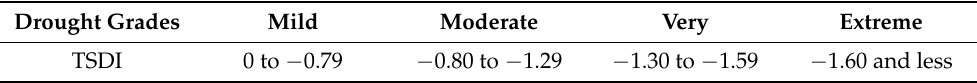
Table 2. Drought grades based on